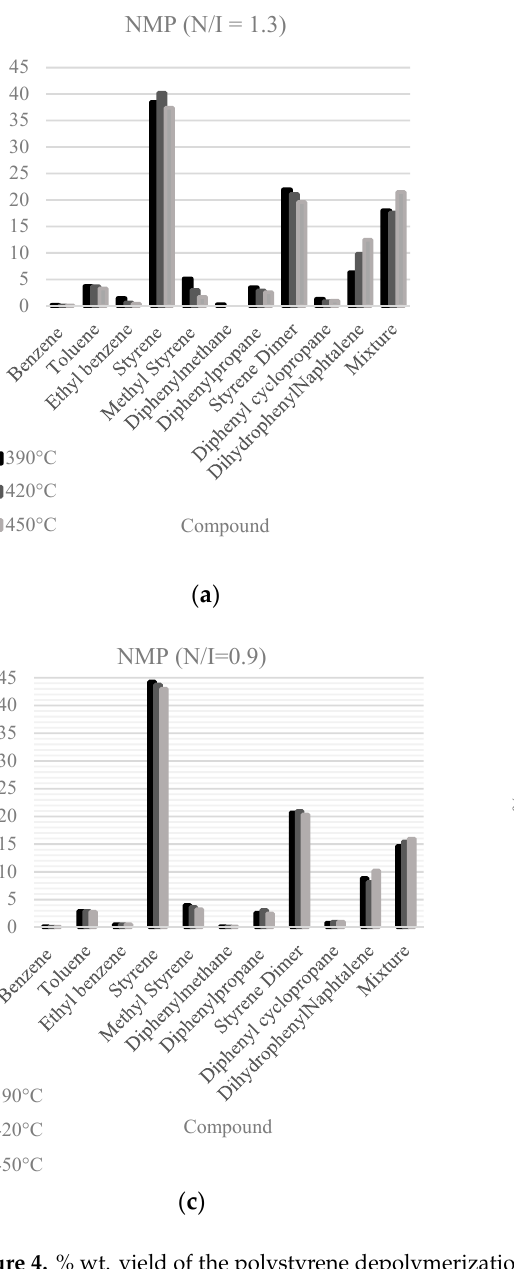
Figure 4. % wt. yield of the polystyrene depolymerization products in the liquid fraction: ( a ) N/I = 1.3, ( b ) N/I = 1.1, ( c ) N/I = 0.9, and ( d ) FRP.